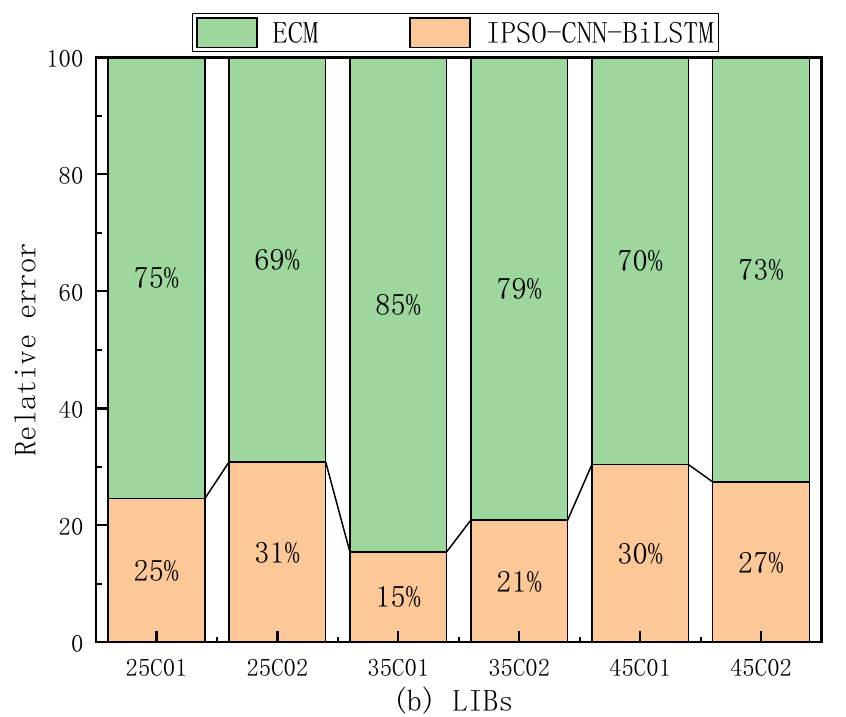
Figure 10. ( a ) Comparison of RMSE coefficient between the proposed improved model and the traditional models. ( b ) Comparison of relative errors between ECM model and IPSO-CNN-BILSTM model.